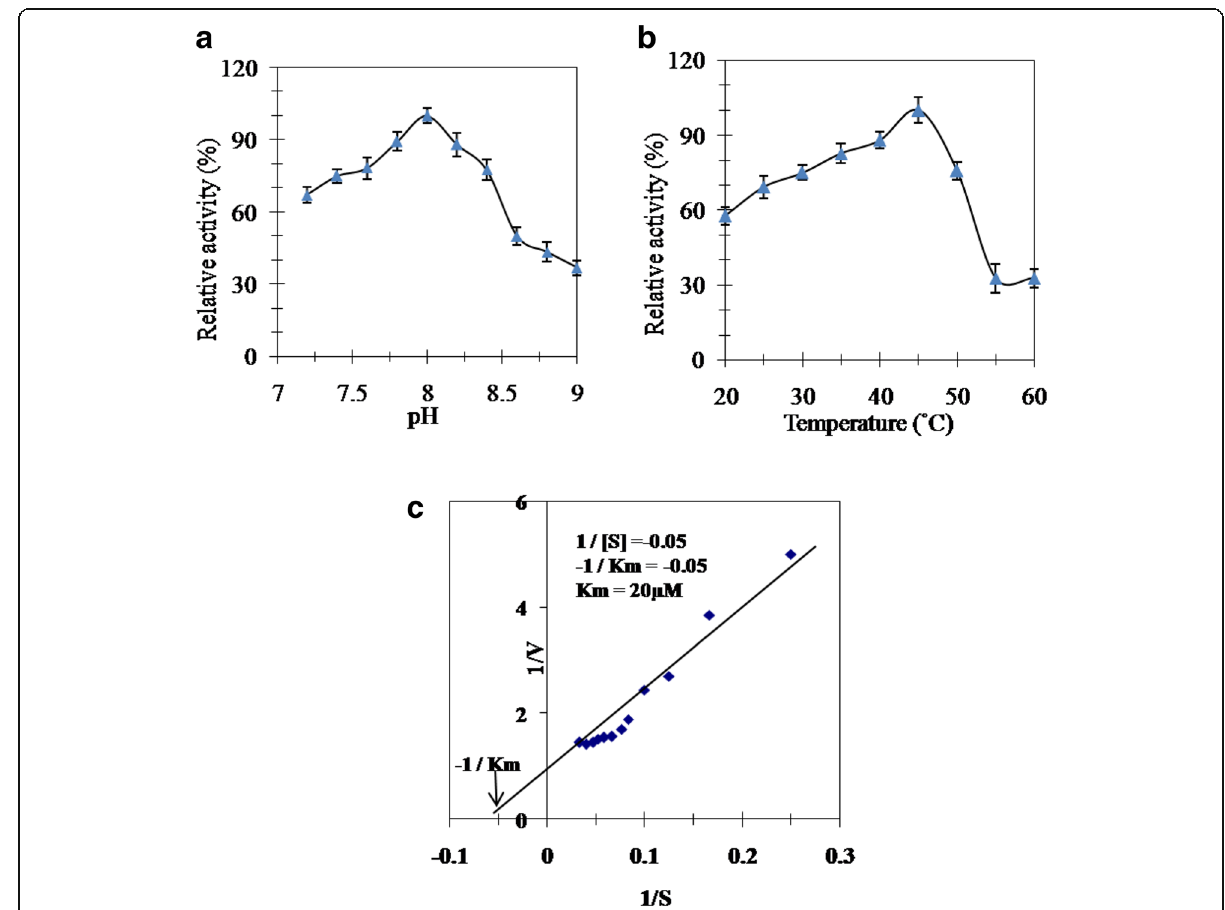
Fig. 3 a Effect of pH on bee venom PLA2 using 0.02 M Tris-HCl buffer, pH (7.2 – 9.0). b Effect of temperature on bee venom PLA2. c Lineweaver- Burk plot relating the reciprocal of the reaction velocity of bee venom PLA2 to phosphatidylcholine